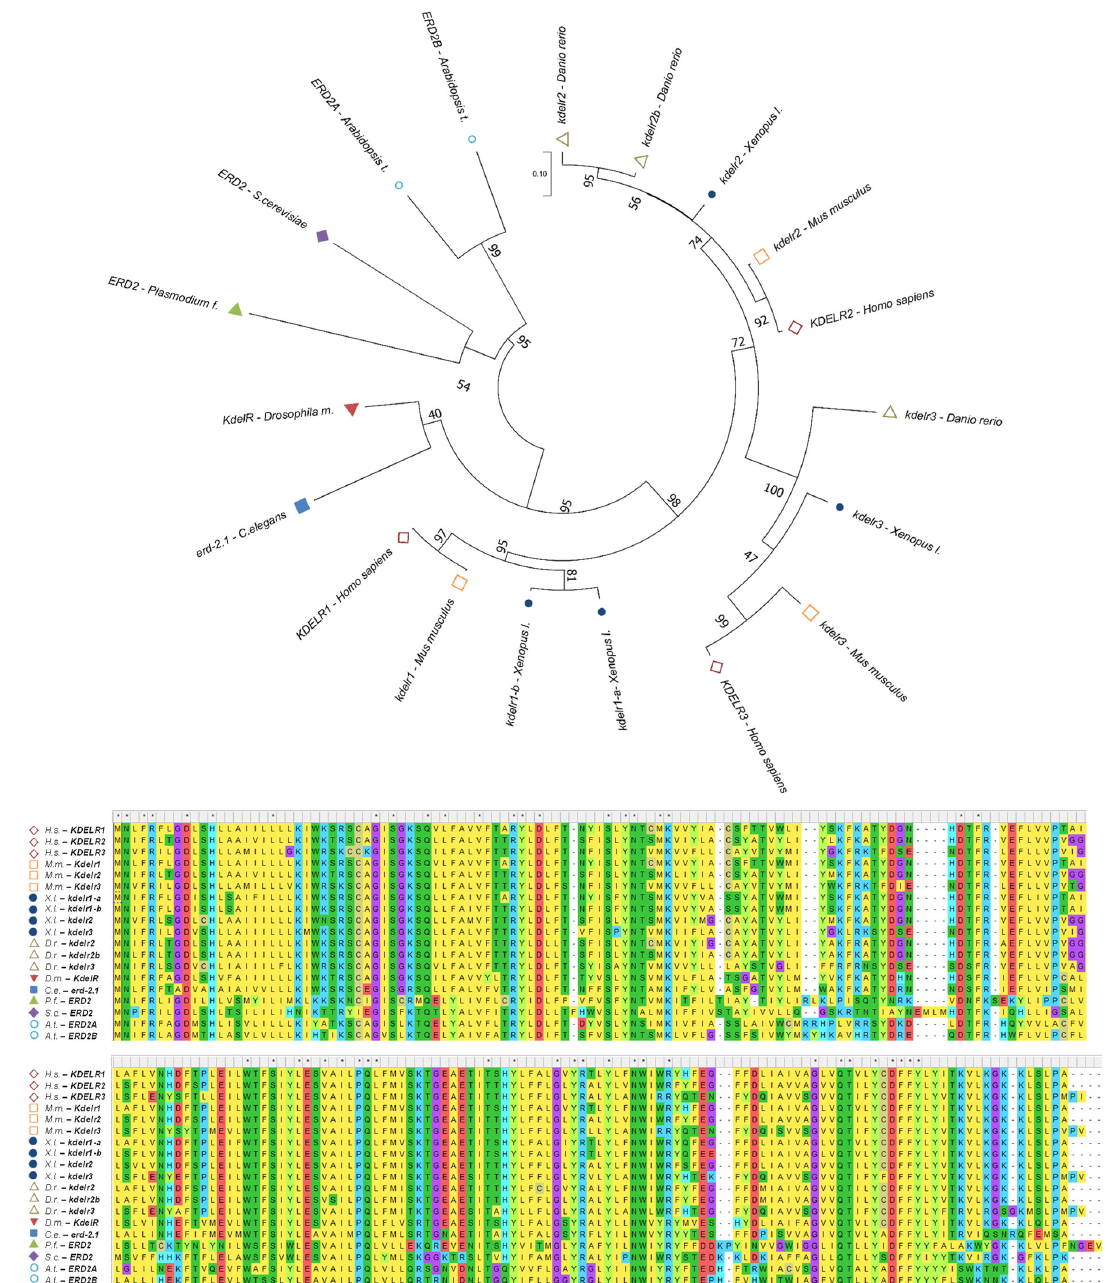
Figure 1. H/KDEL receptors’ orthologues show high levels of conservation among different eukaryotic organisms. Phylogenetic tree showing the evolutionary relationship of KDELRs in several eukaryotic organisms as inferred, from protein sequence alignments, using the maximum likelihood method in MEGA 11 software (version 11, USA) [18] and corrected using the Poisson model. The tree is drawn to scale, with branch lengths in the same units as those of the evolutionary distances used to infer the phylogenetic tree. The evolutionary distances are in the units of the number of amino acid substitutions per site. The branch support values were gained by bootstrapping method (500 iterations). Protein sequences of KDELRs retrieved from Uniprot (Uniprot release 2022_01, Uniprot Consortium) [19] were aligned by ClustalW on MEGA 11 software (version 11, USA) [18]. Asteriks indicate conserved amino acids within sequences. H.s . , Homo sapiens ; M.m ., Mus musculus ; X.l . , Xenopus laevis ; D.r . , Danio rerio ; D.m . , Drosophila melanogaster ;